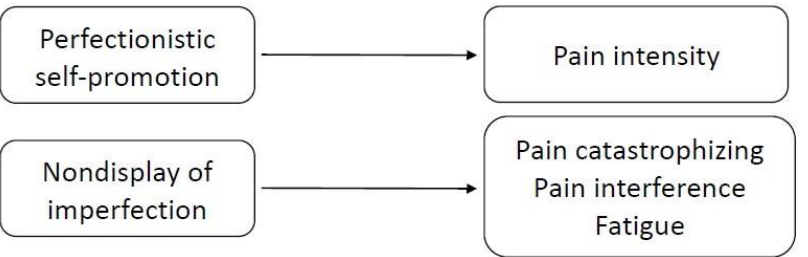
Figure 5. Predictions of pain-related criterion variables from measures of perfectionistic self-presentation.